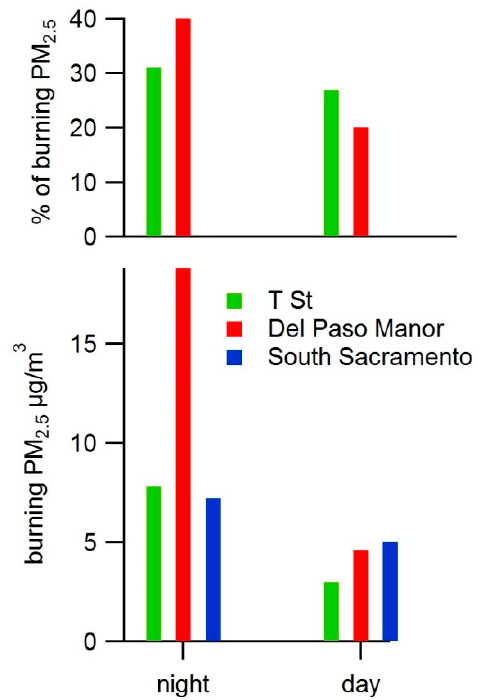
Figure 4. Average fraction of (top figure) and total (bottom figure) residential wood burning PM 2.5 concentrations ( µ g / m 3 ) during two daytime samples (28 and 29 January 2017 at the Del Paso Manor, T Street, and South Sacramento sites) and two nighttime samples (27 through 29 January 2017 at the Del Paso Manor and T Street sites and 15 and 16 January 2017 at the South Sacramento site).